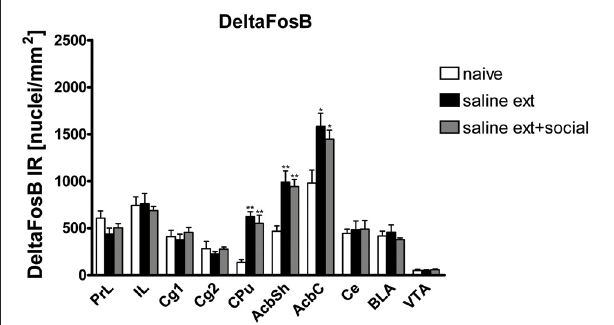
FIGURE 3 | Cocaine CPP reinstatement-associated (cid:2) FosB expression is increased similarly in the dorsal striatum (CPu), nucleus accumbens shell (AcbSh), and core (AcbC) of rats that underwent extinction before the cocaine priming in absence (sal ext) or presence of social interaction (sal ext + social). Shown are (cid:2) FosB positive immuno-reactive nuclei per mm 2 of the respective brain area. Shown are group means ± SEM. ∗ P < 0 . 05 and ∗∗ P < 0 . 01 compared to naive group. Brain area abbreviations follow the nomenclature of Paxinos and Watson (Paxinos and Watson,